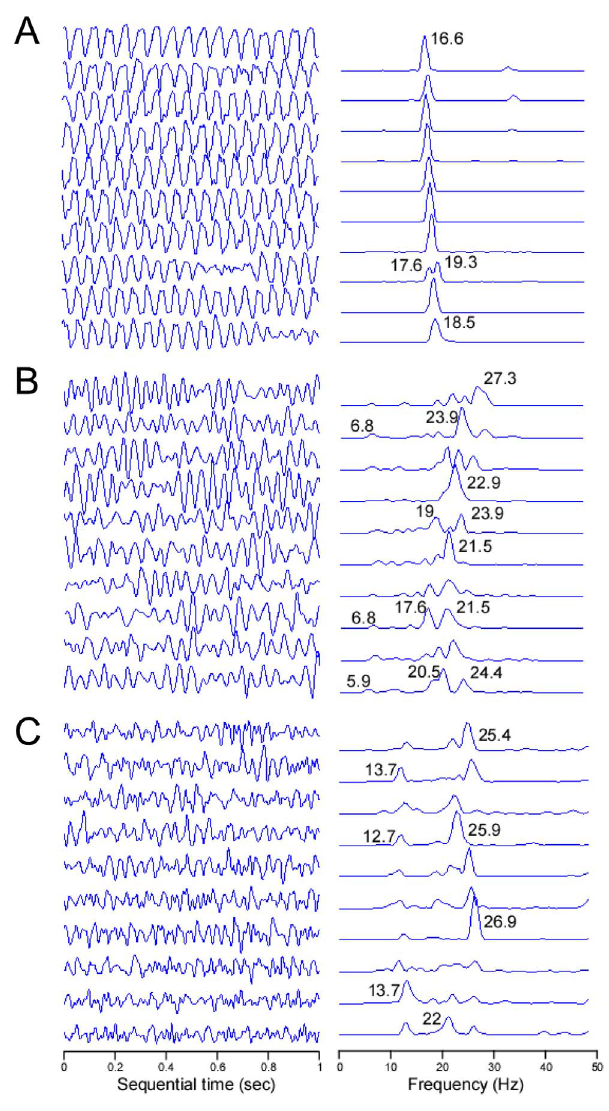
Figure 4. Time course of spectral properties of VF in a control and exercised sample rats. Ten consecutive 1-second long pseudo- ECG episodes of VF (from early at top to late at bottom) with their corresponding power spectra for sample animals from the CTRL (A), ST (B) and LT (C) groups, respectively. Numbers on power spectra traces indicate values of significant peaks in